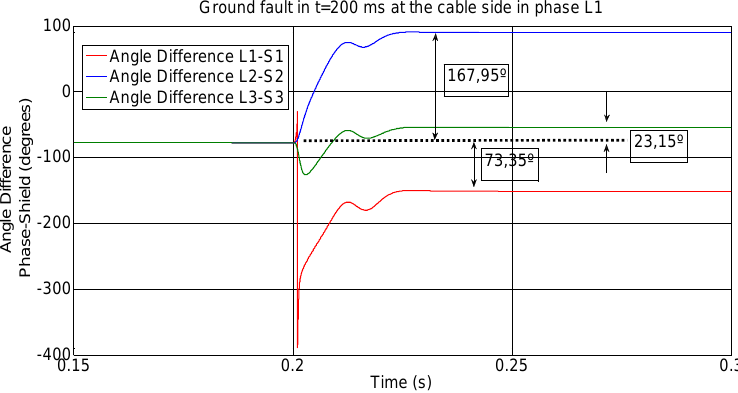
Figure 11. Angular differences with ground fault at the cable line side in phase L1.